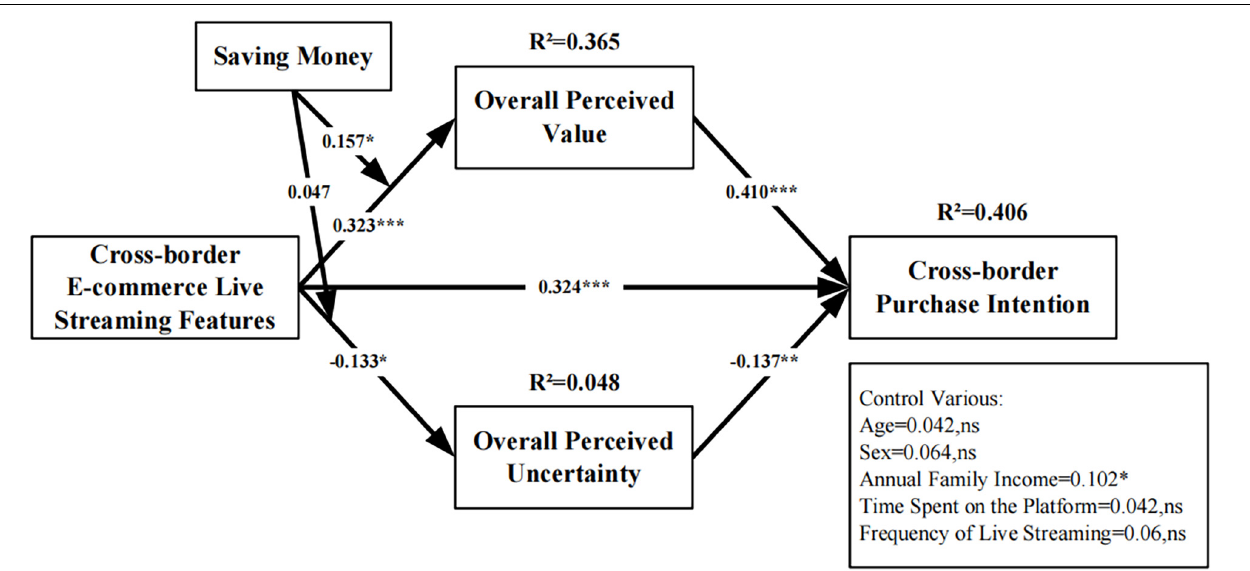
FIGURE 2 | Results of the research model. * p < 0.05, ** p < 0.01, and *** p < 0.001. n.s., not